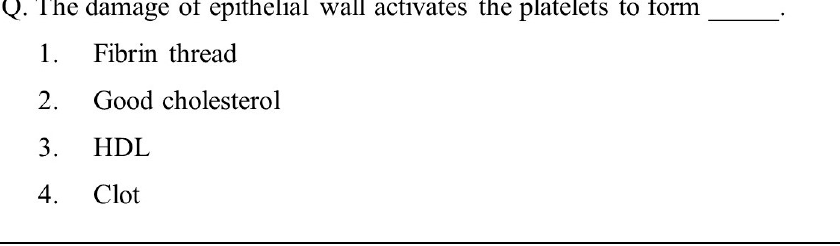
Figure 2. Example of a multiple-choice